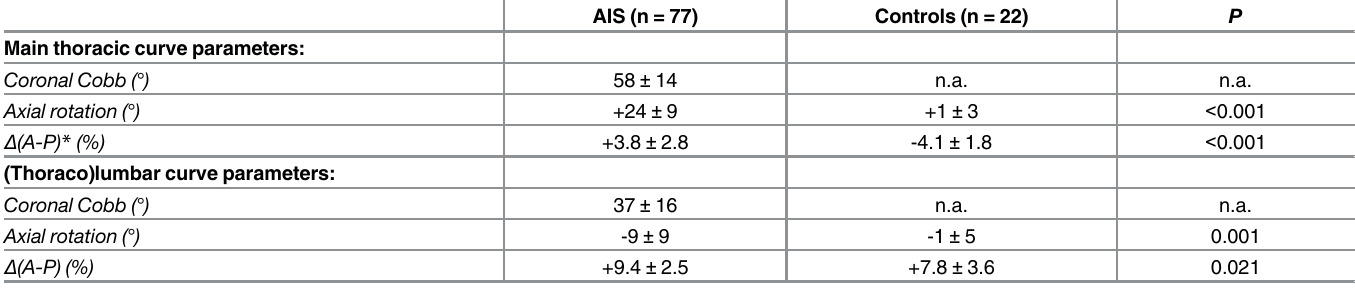
and twenty-two controls are shown in Table 1. All CT scans of the AIS cases and controls included all levels from T4 to S1, the average radiation dose was 10 mSv. Anterior overgrowth in AIS as compared to controls All thoracic AIS curves were significantly longer anterior than posterior, and normalized ante- rior length was greater in scoliosis (+3.8±2.8%) than in controls (-4.1±1.8%) over the same seg- ments ( P < 0.001; Table 2). Thoracic AIS curves were on average 7.9% longer anteriorly over the same segments than the controls. As a reference, the mean absolute anterior and posterior length of the thoracic AIS curves was 153±33mm and 147±31mm, respectively. The (thoraco) lumbar AIS curves were 9.4±2.5% longer anteriorly, whereas the lumbar spines of controls Table 2. Differences in three-dimensional measurements are shown for adolescent idiopathic scoliosis (AIS) subjects and the thoracic (T4-T12) and lumbar (L1-L5) spine in matched controls. AIS (n = 77) Controls (n = 22) P Main thoracic curve parameters: